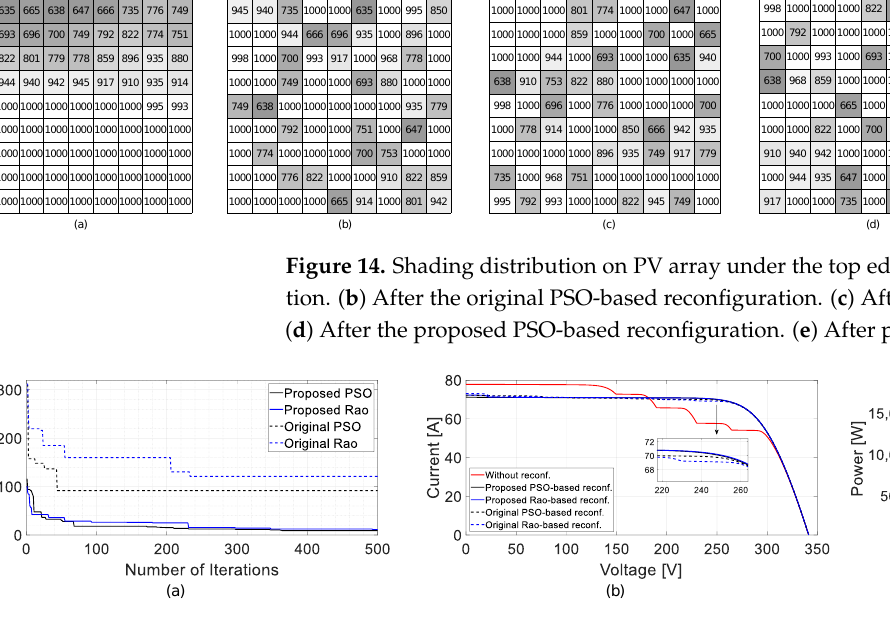
Figure 15. Comparison of characteristics of PV array under the top edge of the cloud. ( a ) Objective function over iterations. ( b ) I-V curves. ( c ) P-V curves.